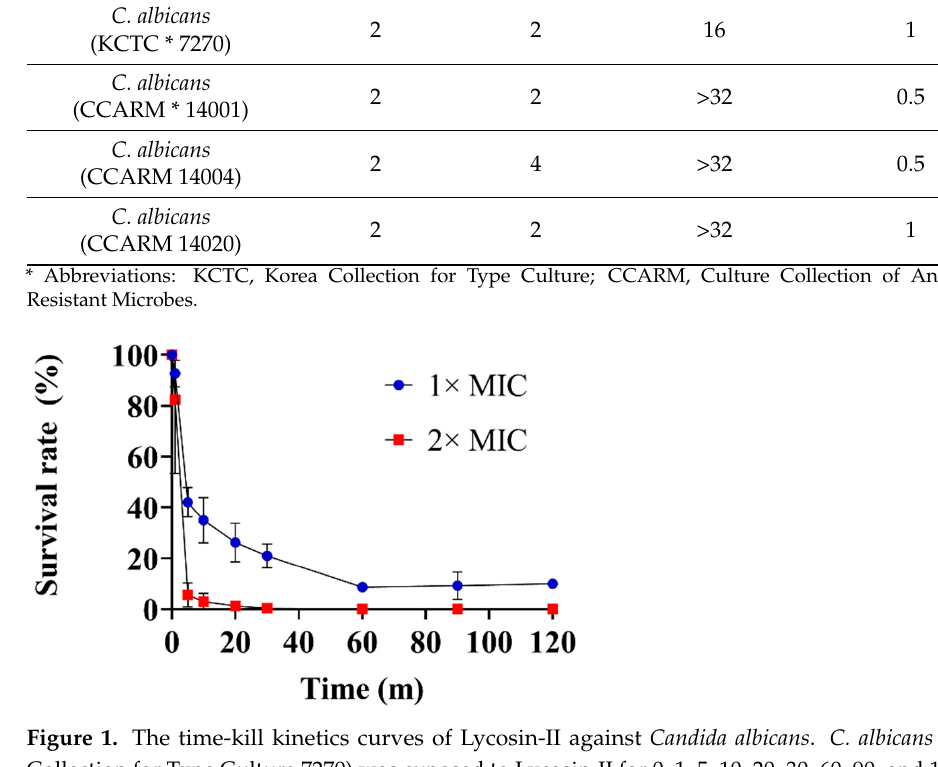
Table 1. Minimum inhibitory concentrations (MICs) of Lycosin-II and antifungal agents against Candida albicans . Strains